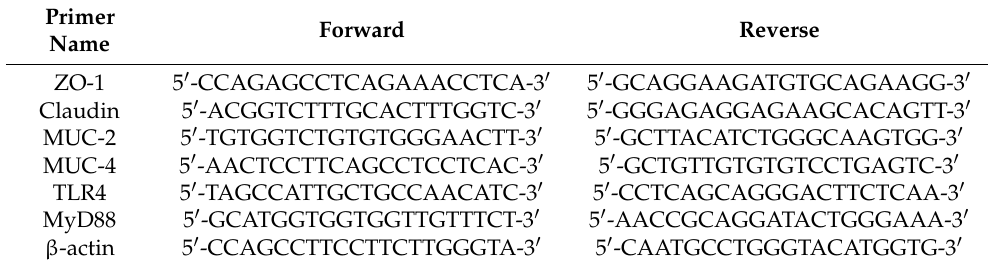
Table 1. Primer sequences of